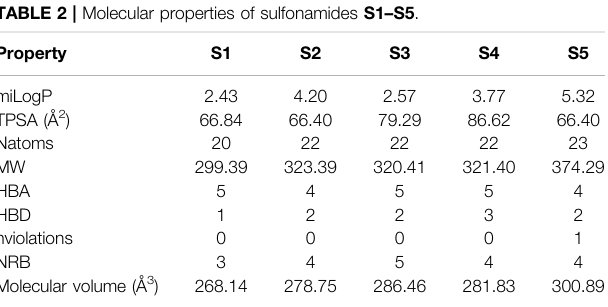
TABLE 2 | Molecular properties of sulfonamides S1 – S5 . Property